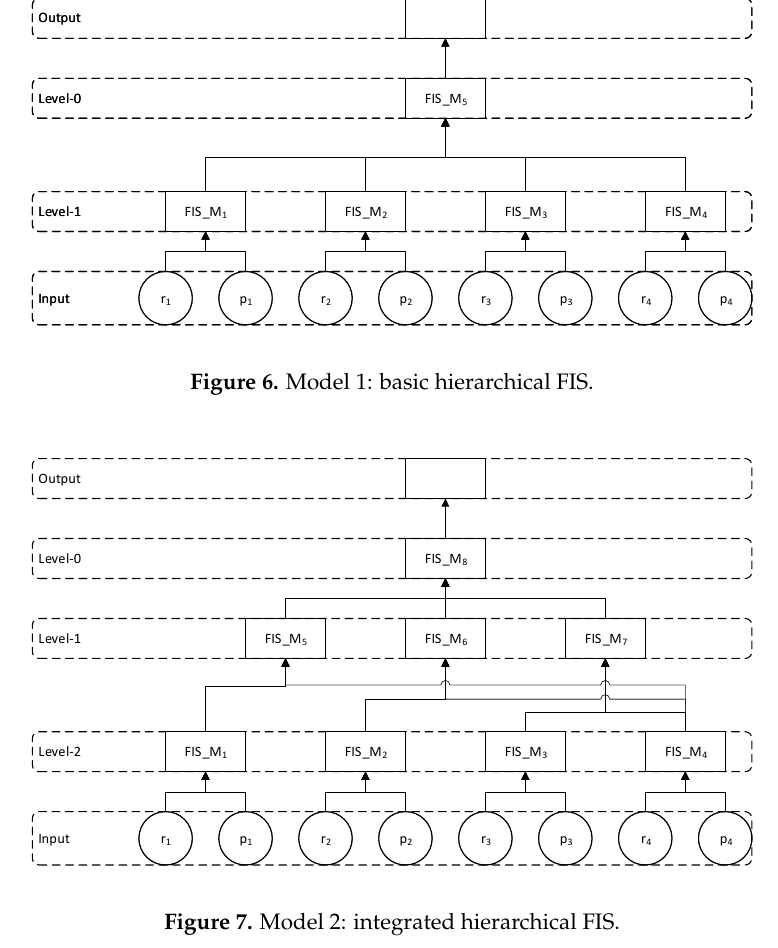
Figure 7. Model 2: integrated hierarchical